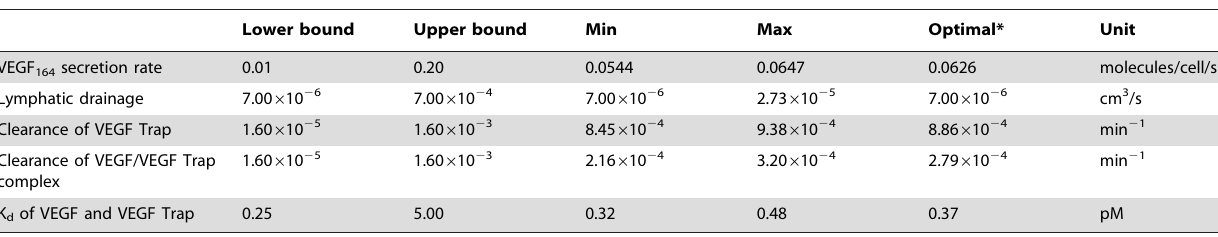
Table 6. Summary of parameter optimization (n=20).